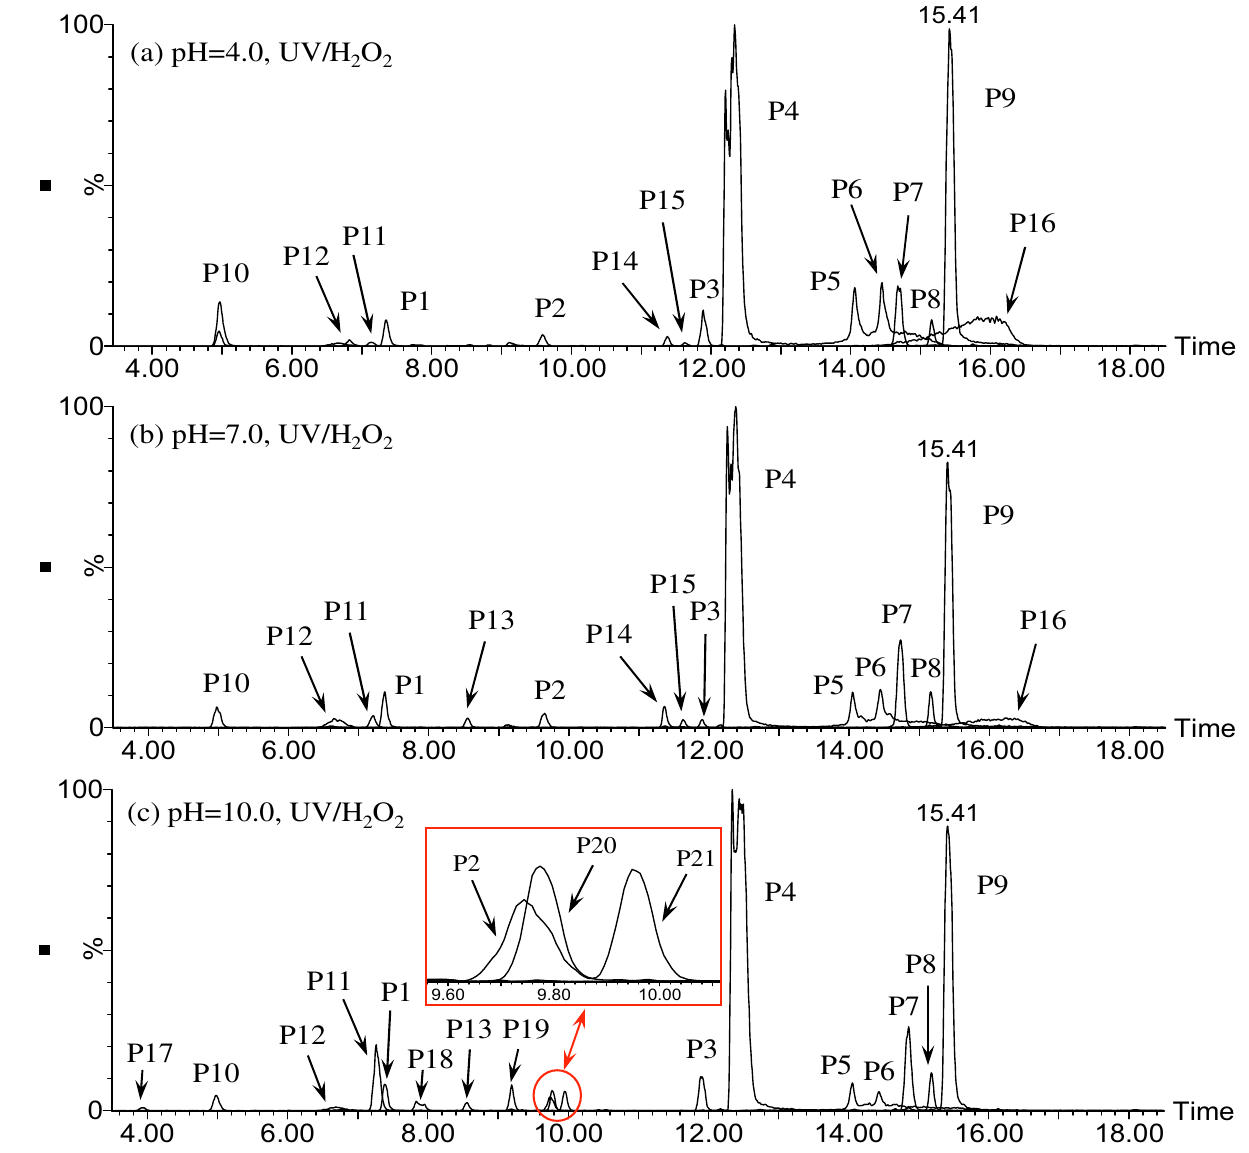
Figure 4. The extracted ion chromatograms (EICs) of ATZ solution after 90 min irradiation in UV/H 2 O 2 process: ( a ) pH = 4.0; ( b ) pH = 7.0; (c) pH =